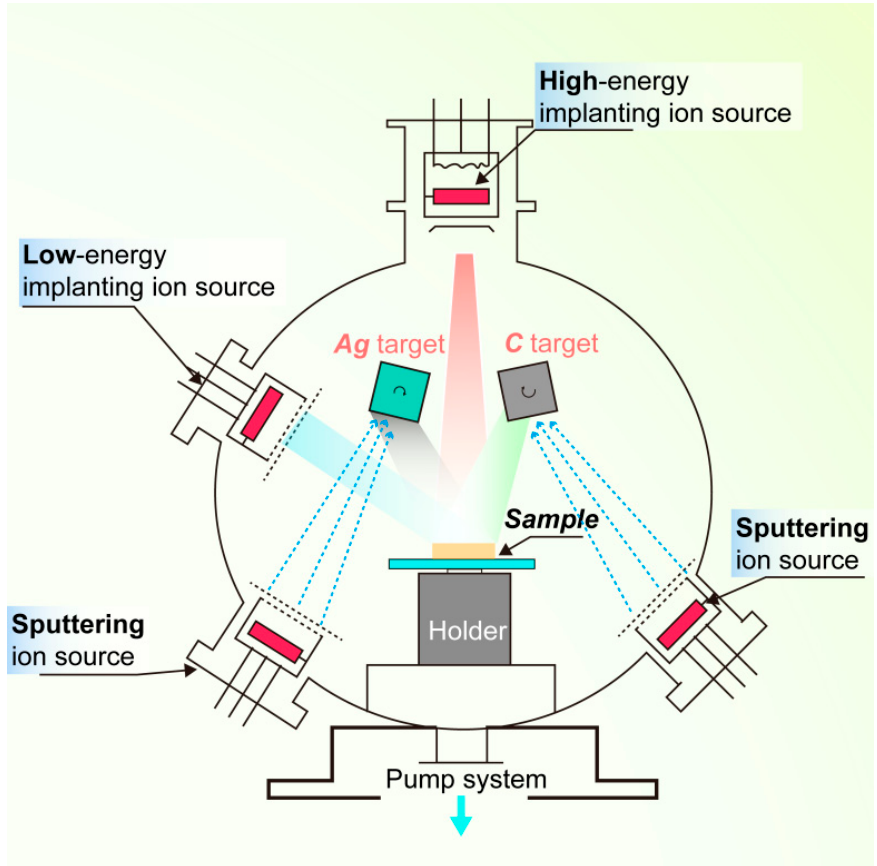
Figure 2. Schematic diagram of the multi-ion beam assisted deposition (IBAD) system used. Table 1. Ag sputtering current and atomic percentage of six a:C-Ag x film samples.